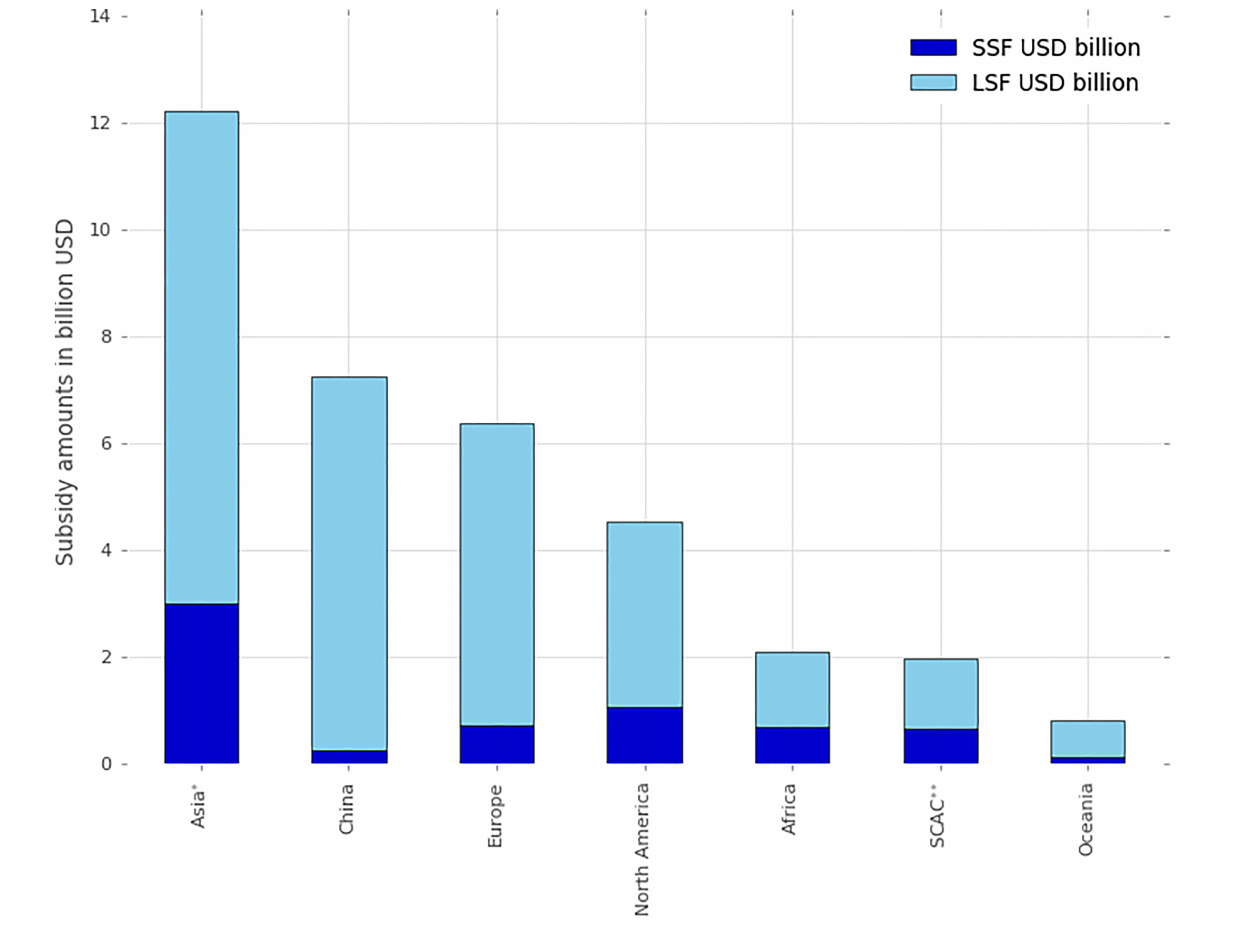
FIGURE 4 | Subsidy amounts by major region broken down into SSF and LSF for 2018 (constant USD), showing China separately. *Rest of Asia excluding China, **South, Central America and